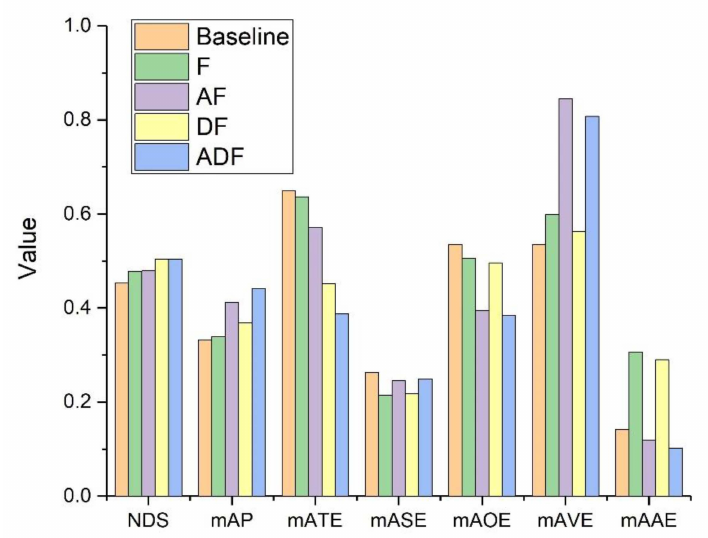
Figure 15. Histogram of overall performance ablation experiment on the nuScenes test